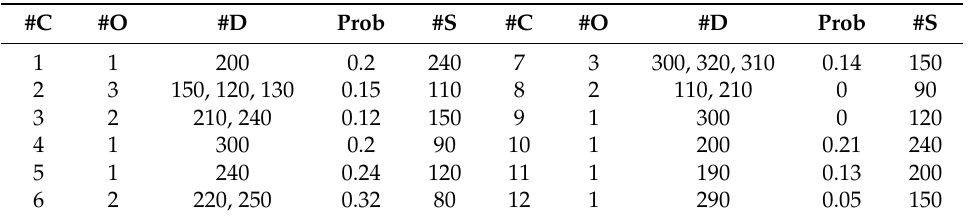
Table 1. Details of the customers.